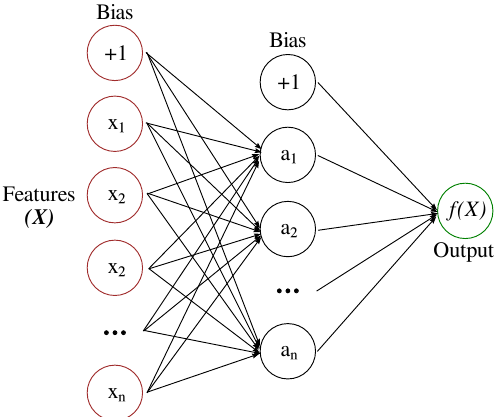
Figure 2. Multilayer perceptron (MLP) with one hidden